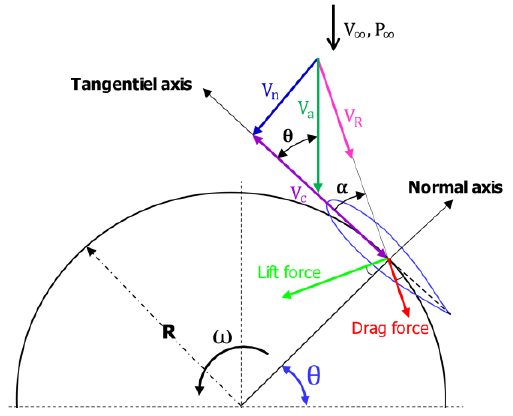
Figure 4. Flow velocities diagram of Darrieus VAWT airfoil.